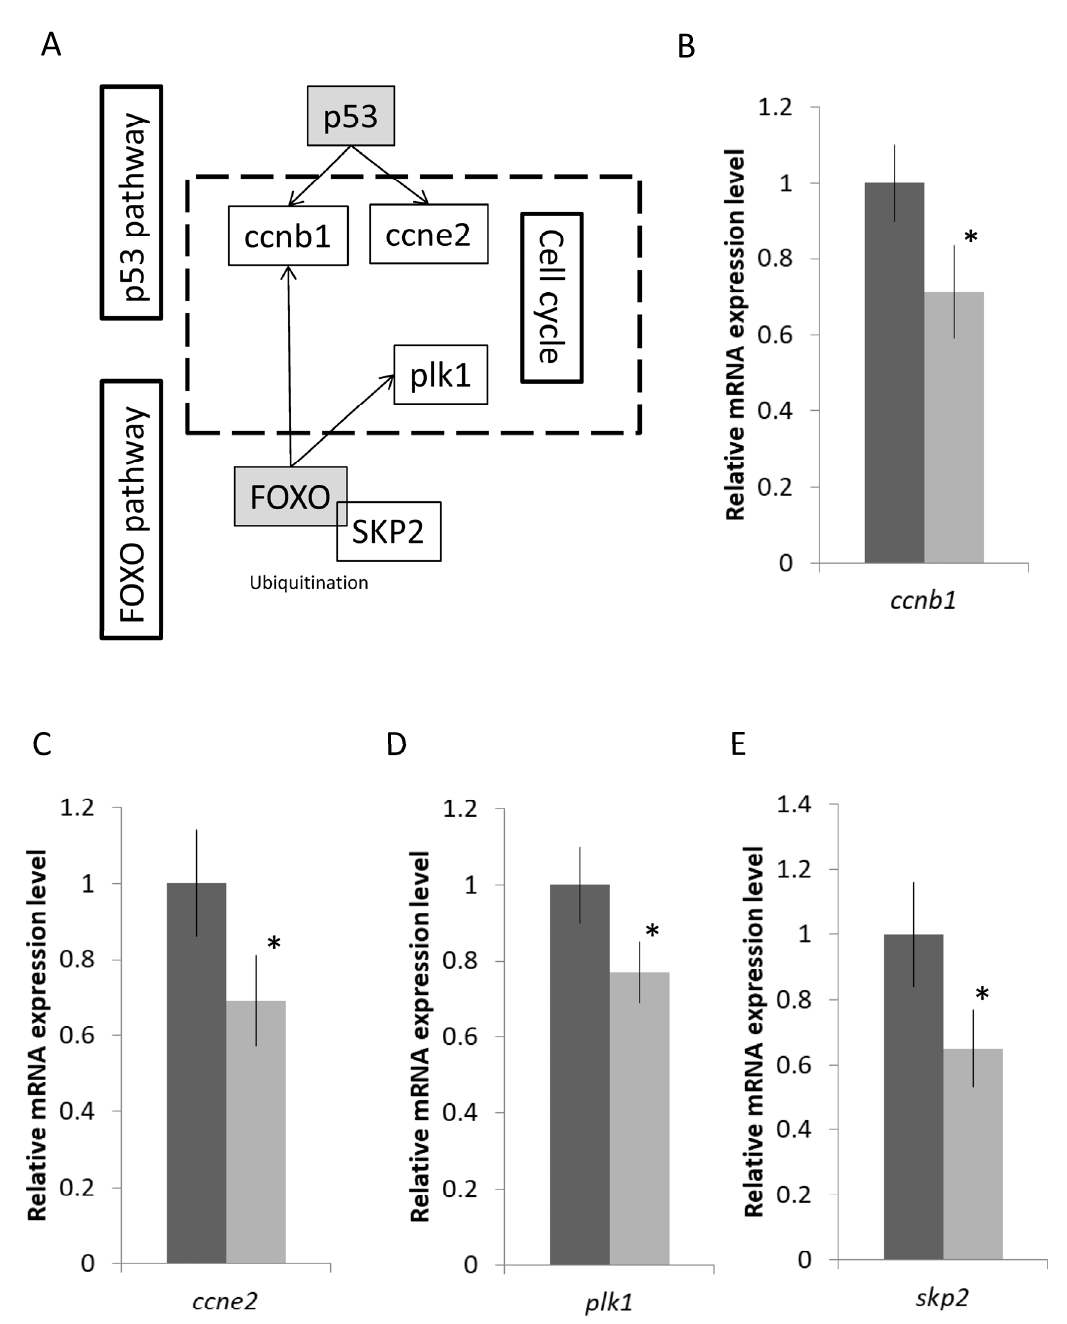
Figure 4. Hypo-osmotic stress influences the FoxO, p53 pathways, and cell cycle in gill cells. ( A ) The relationship among FoxO, p53, and cell cycle. ( B – E ) Validations of the mRNA gene expression levels of the selected transcripts by real time qPCR. Down regulation of the selected transcripts ( ccnb1 ; ccne2; plk1 ; and skp2 ) in the pathways. Results matched with the sequencing data. n = 5; mean ± s.e., * indicated p < 0.05.